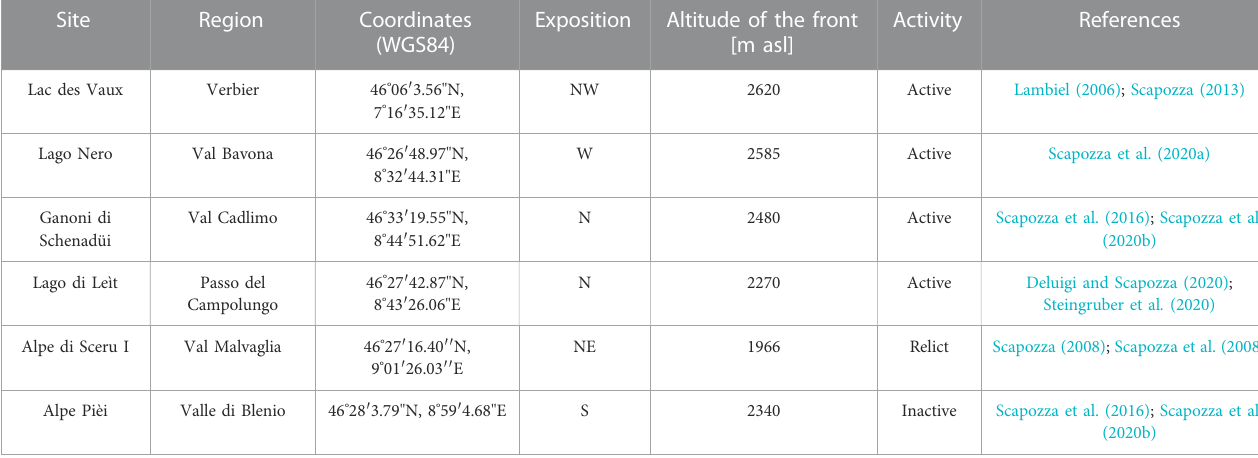
TABLE 1 Main characteristics of the rock glaciers in this